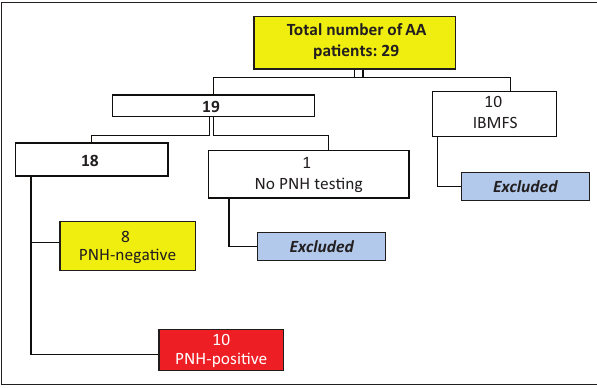
Total number of AA pa(cid:16)ents: 29